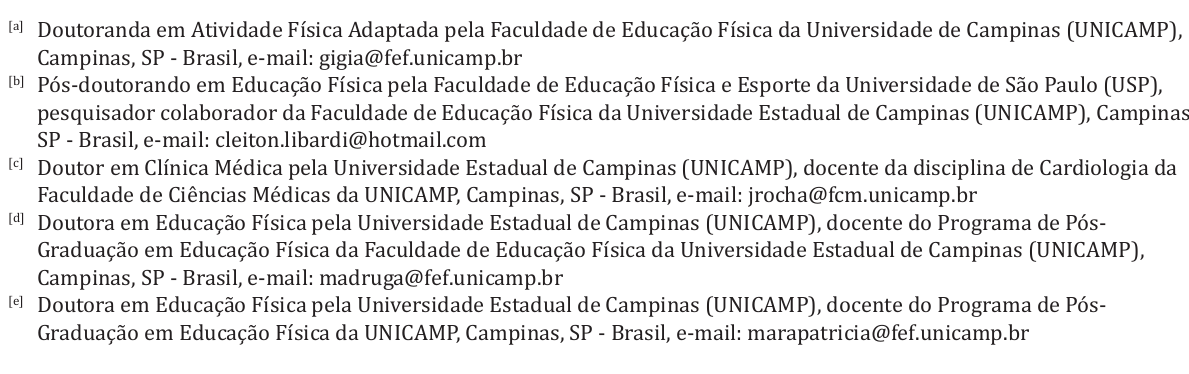
tabólica (SM) de homens de meia-idade. Métodos : Foram selecionados 42 homens clinicamente saudáveis distribuídos em quatro grupos: TA (n = 13), TF (n = 9), TC (n = 10) e grupo controle (GC, n = 10). Os trei- namentos foram compostos por duas etapas (E1 e E2) com duração de oito semanas cada, e frequência de três sessões/semana (TF: dez exercícios com 3 x 8-10 RM; TA: 60 min. de caminhada ou corrida a 55-85% ; TC: seis exercícios com 3 x 8-10 RM, seguidos de 30 min. de caminhada ou corrida a 55-85% VO VO2 pico